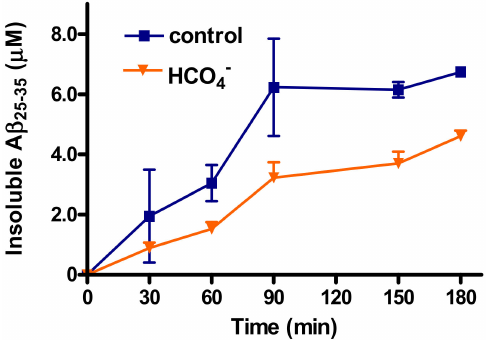
(two-electron oxidant) or CO 3 •− (one-electron oxidant) after 24 h aggregation.